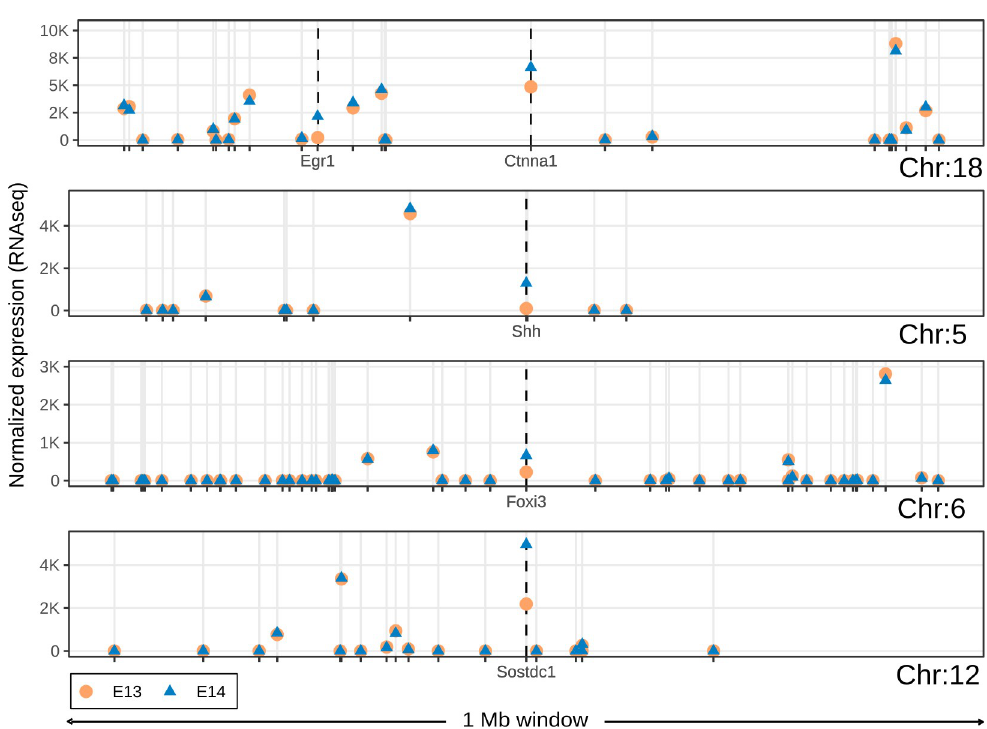
Fig 4. Only tooth developmental genes are differentially expressed within 1 Mb windows in the developing mouse molar. Median expression levels of the tooth developmental genes Ctnna1 , Shh , Foxi3 and Sostdc1 and their neighbouring genes at developmental stages E13 and E14. Regardless of their expression level, the surrounding genes show little change between the two stages whereas the tooth genes are upregulated. Egr1 in the 1 Mb window of Ctnna1 is also a tooth developmental